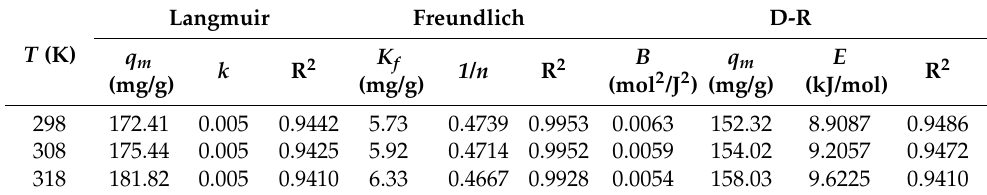
Table 2. Relative parameters of adsorption isotherms models.